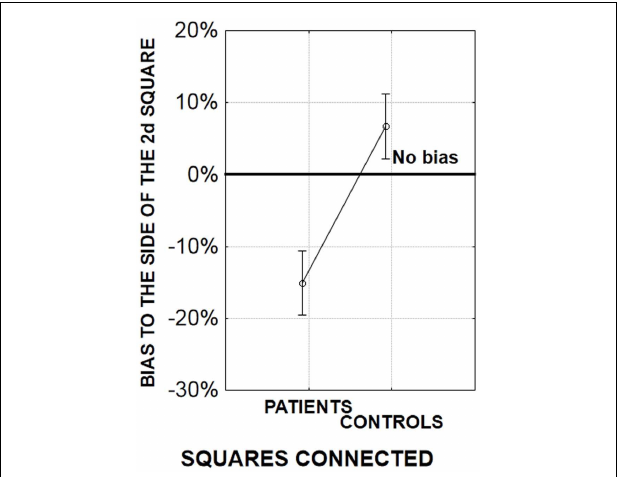
FIGURE 6 |Amplitude of the bias (in %) to the side of the first or second stimulus for an asynchrony of 17ms . A negative bias corresponds to a bias to the side of the first stimulus (in patients), whereas a positive bias corresponds to a bias to the side of the second stimulus (in healthy participants). In the present experiment, there were two possible locations for the squares, one on the left part and one on the right part of the screen. As a consequence, the location of the second square was always predictable (similar results were observed when the location of the second square was more uncertain, Lalanne et al., 2012c).The squares were either connected (the displayed graph) or unconnected (data not shown, but see Lalanne et al.,